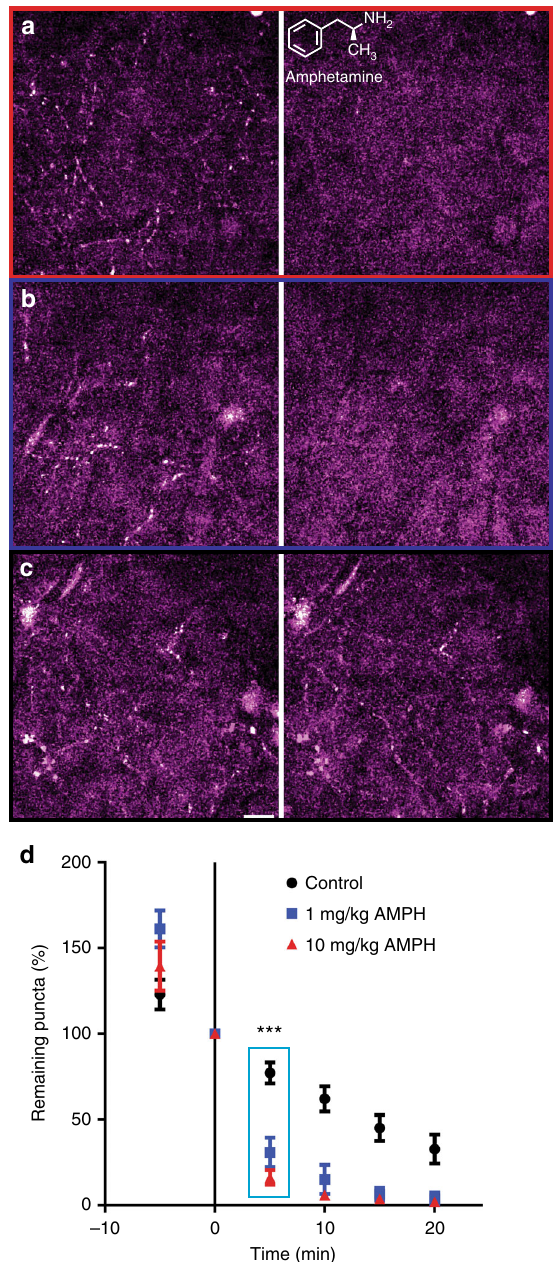
Fig. 7 Amphetamine releases FFN270 from NE projections in vivo. Representative images of FFN270 in Layer 1 of the barrel cortex in living mice taken before and 5 min after injection of amphetamine (AMPH). The left column includes images acquired before i.p. administration of a high dose (10 mg/kg, a ), low dose (1 mg/kg, b ) and a vehicle (saline only, c ), while the right column is post-injection. d Quanti fi cation of the number of puncta before and after each AMPH condition over a 25 min time course. After 5 min, there was already a signi fi cant decrease in remaining FFN270 puncta in the high (83.9 ± 4.4%, n = 5) and low (69.1 ± 8.6%, n = 6) AMPH condition when compared to the control (22.8 ± 6.1%, n = 7 , P < 0.0003 for both AMPH conditions, one-way ANOVA Dunnett test). All data listed as mean ± SEM. Scale bar: 10 µ release properties in vivo, consistent with the fi ndings ex vivo. In contrast to results in the brain slice, however, we were unable to fi t the in vivo ChR + axons to a double Gaussian with well-de fi ned low and high releasing populations.